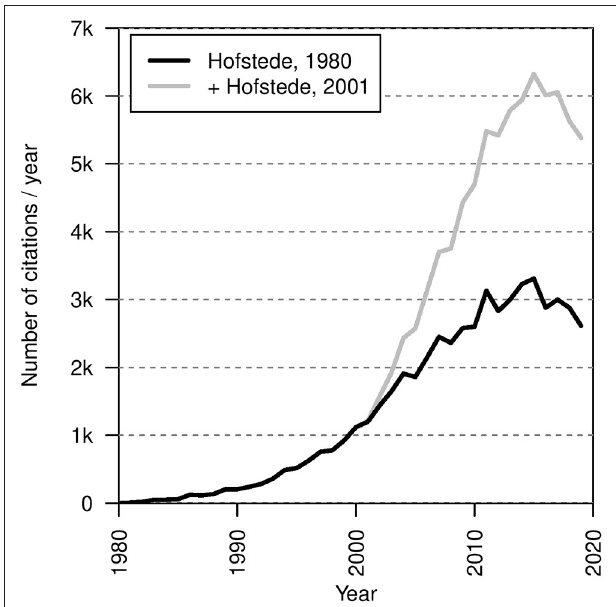
FIGURE 1 | Number of publications in thousands citing Hofstede (1980, 2001) per year (1980–2019). Data taken from a Google Scholar (scholar.google.com) search for all publications. The black line indicates the number of citations of the seminal investigation only (Hofstede, 1980). The gray line includes citations of the second edition (Hofstede, 2001) in addition to the seminal